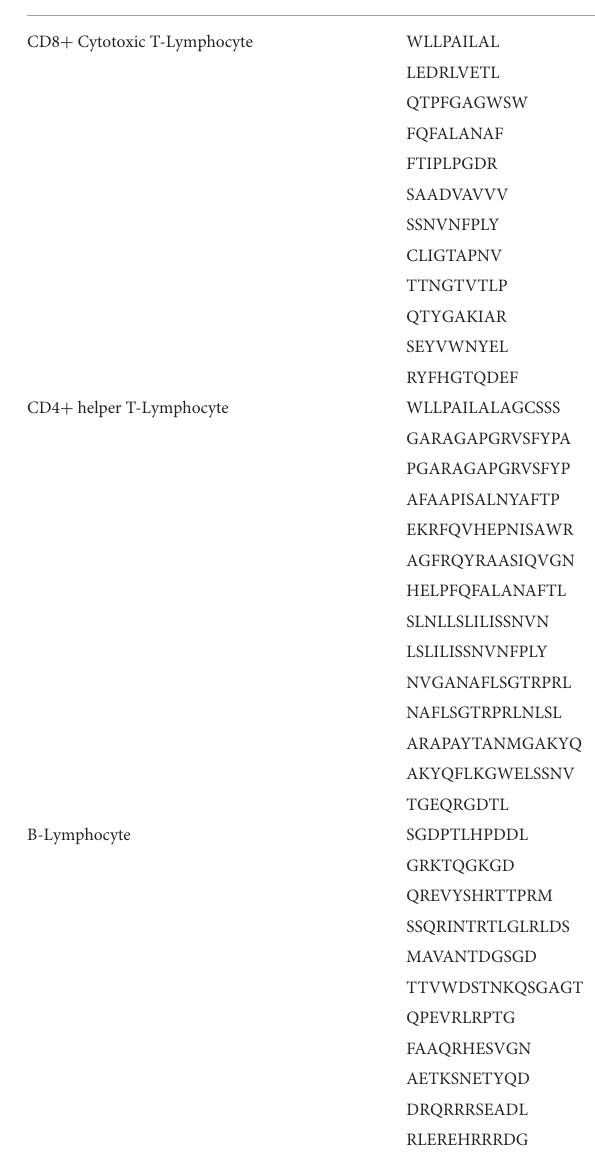
TABLE 1 List of epitope candidates to design